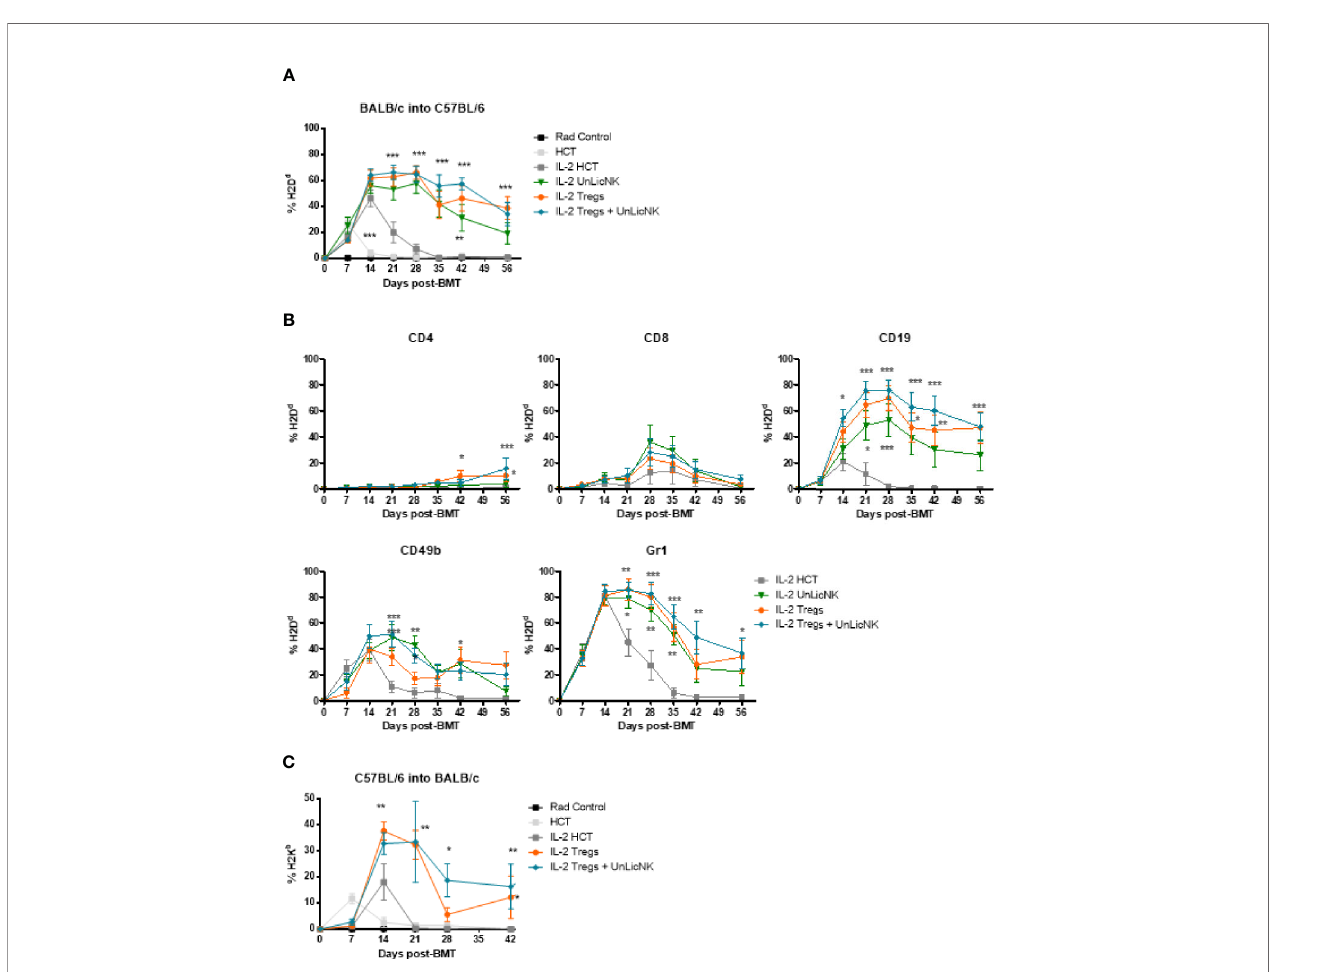
FIGURE 7 | Immune reconstitution after infusion of host type UnLicNK cells and Tregs in NMAC allogeneic HCT. (A) Percentage of H2Dd + donor cells after NMAC HCT is shown. (B) Percentage of H2Dd + donor cells for gated CD4 + , CD8 + , CD19 + , CD3 - CD49b + , CD11c + , and Gr1 + cells is shown. (C) Percentage of H2K b+ donor cells after NMAC HCT is shown. Data is representative of three independent experiments with n=4 – 5 per group (mean ± SEM). One-way ANOVA or Two-Way ANOVA was used to assess signi fi cance. Signi fi cant differences are displayed for comparisons with the IL-2 HCT control group (*p<0.05, **p<0.01,